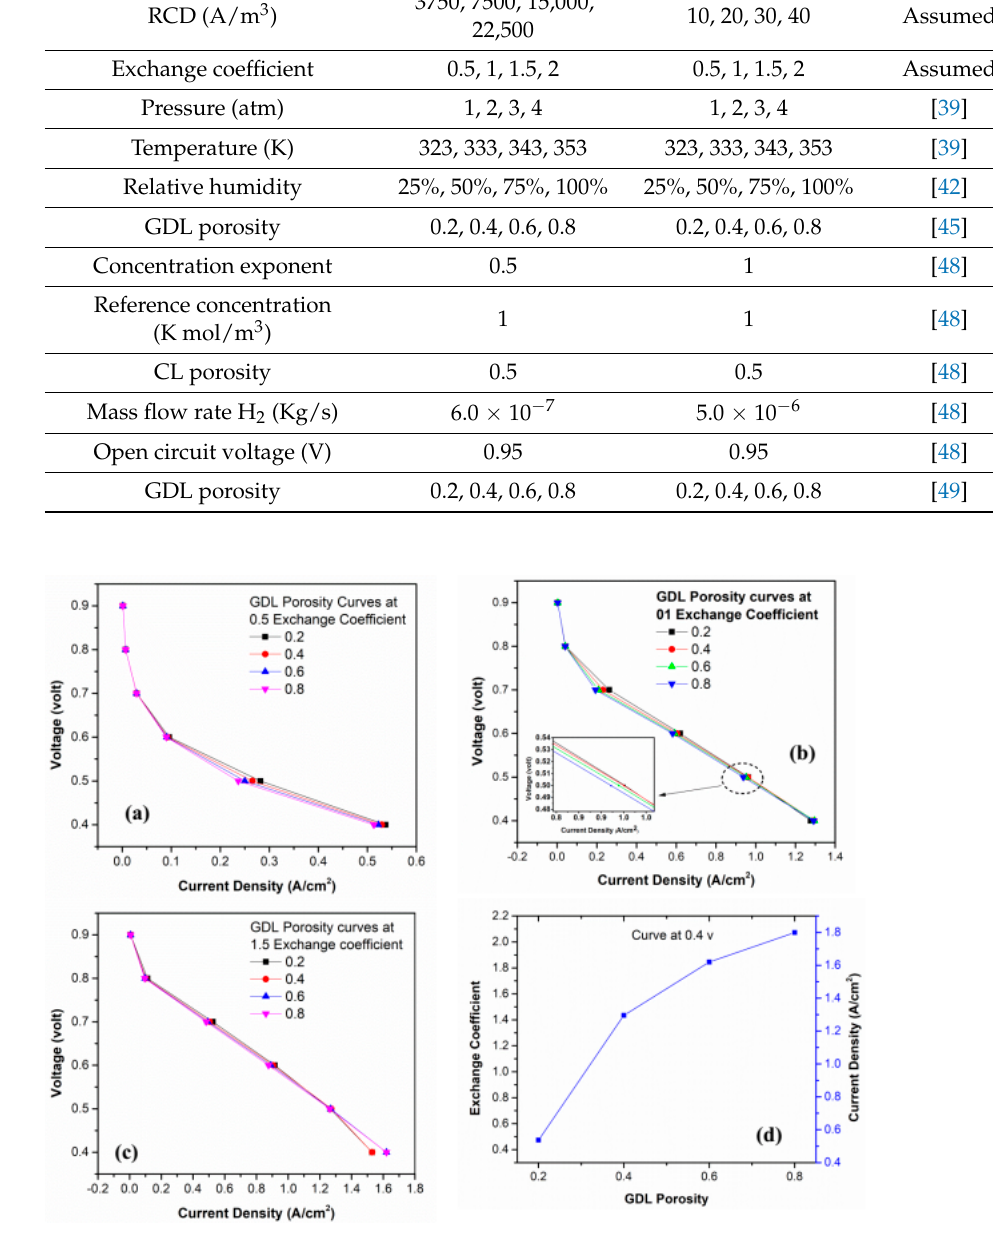
Figure 10. GDL porosity curves at exchange coefficient’s values: ( a ) 0.5; ( b ) 01; ( c ) 1.5; and ( d ) Polarization curve between exchange coefficient and GDL porosity at 0.4 v. Table 2. Operating and electrochemical parameters of PEMFC.